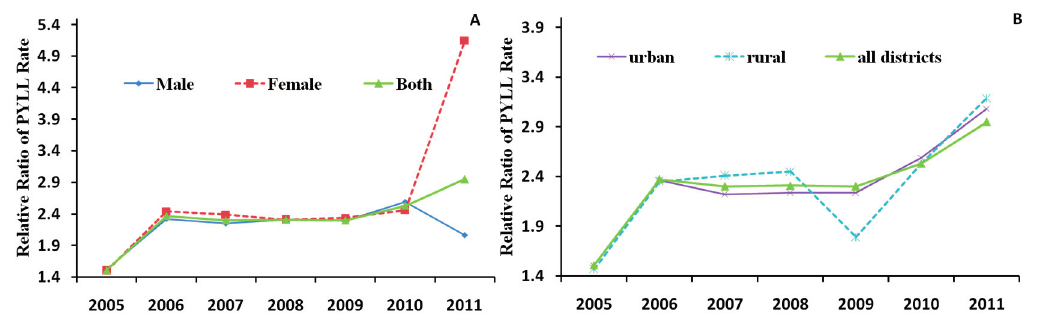
Figure 5. The change of RRs of PYLL rate by ( A ) sex and ( B ) district in China,